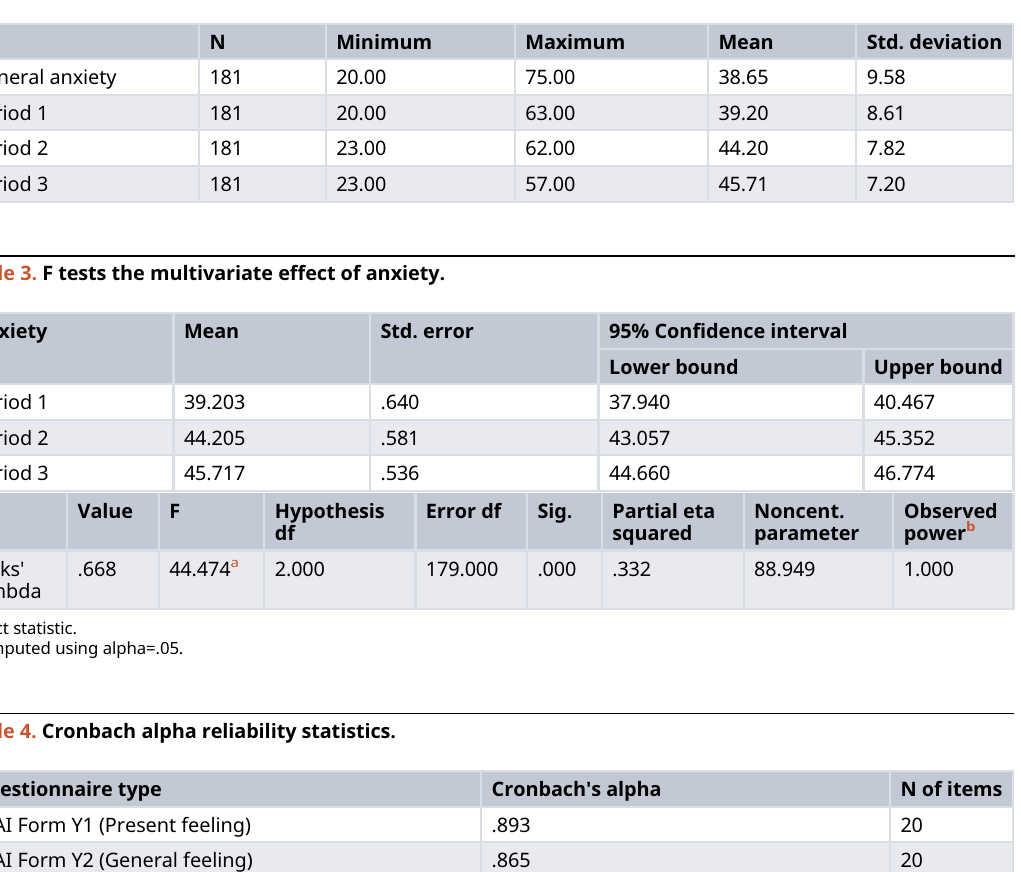
Table 2. Anxiety level.